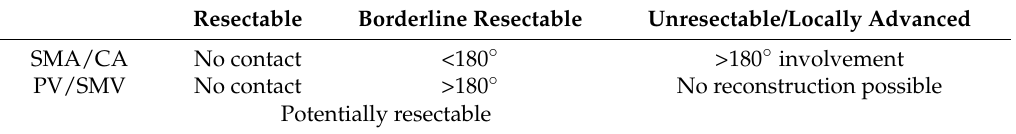
Table 1. Current concept of resectability (definitions vary slightly between major